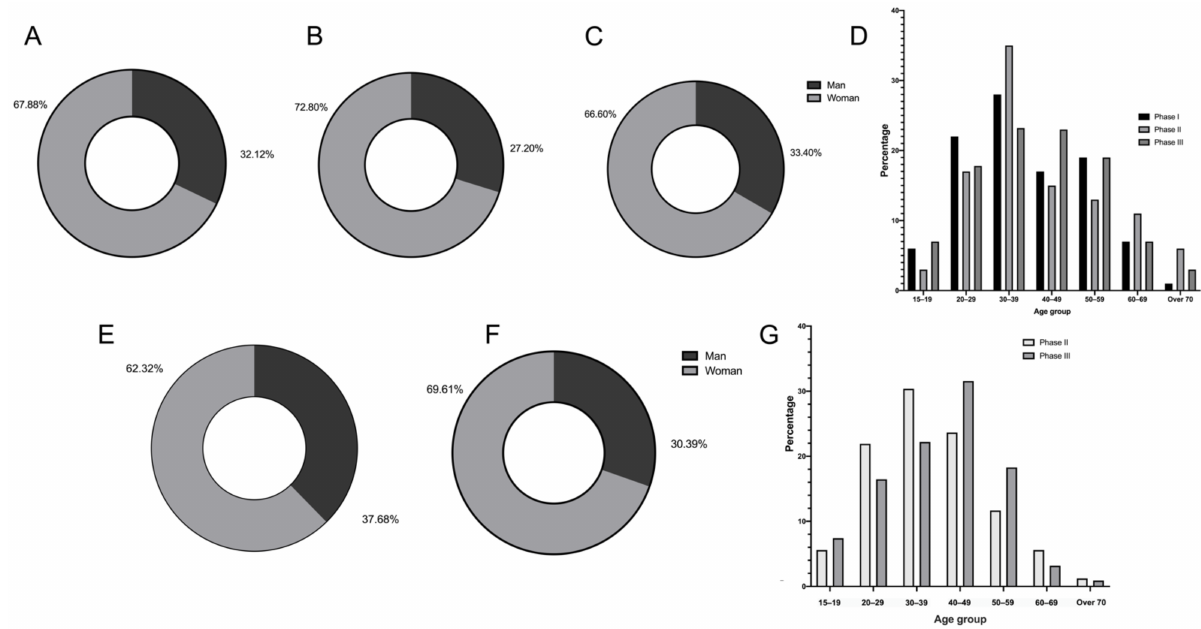
Figure 1. Distribution of genders and ages among online consultants. ( A ) Gender ratio of Phase I of dental treatment. ( B ) Gender ratio of Phase II of dental treatment. ( C ) Gender ratio of Phase III of dental treatment. ( D ) Age distribution among 3 phases of dental treatment. ( E ) Gender ratio of Phase II of online consultation. ( F ) Gender ratio of Phase III of d online consultation. ( G ) Age